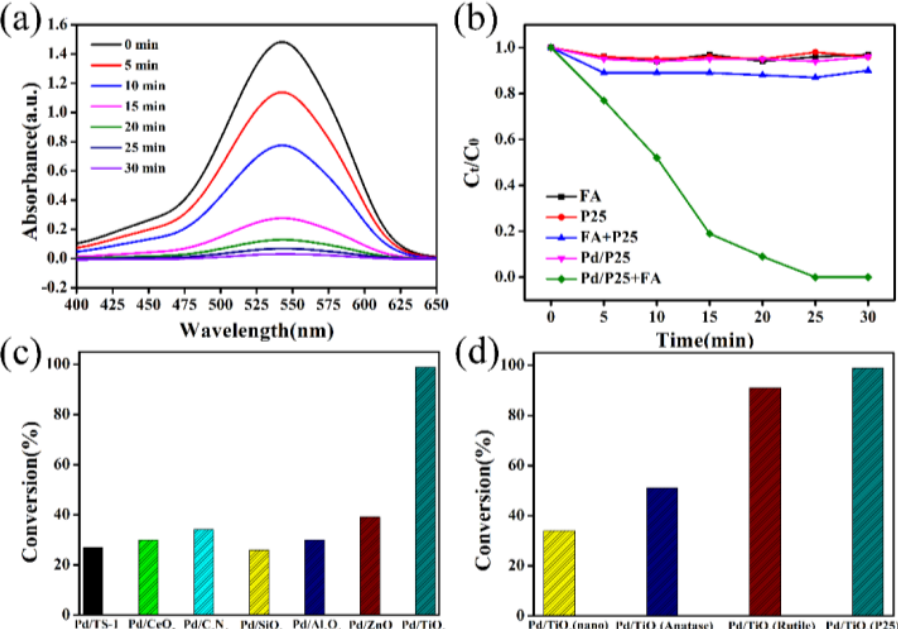
Figure 5. ( a ) UV-vis spectra for the reduction of Cr (VI) to Cr (III) by using HCOOH (K 2 Cr 2 O 7 50 mg/L, HCOOH 73 μL) with Pd/TiO 2 catalyst (10 mg); ( b ) the control experiment on the catalytic reduction of Cr (VI); ( c , d ) the effects of different catalysts on the reduction of Cr (VI).